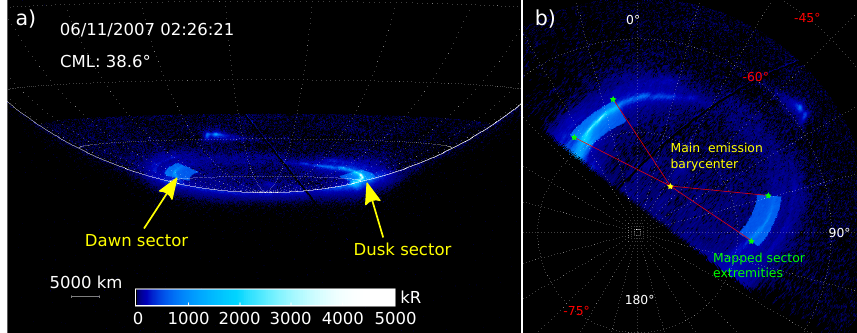
Figure 1. Panel (a) shows a background subtracted HST ACS image of the southern aurora of Jupiter. The brightness of the two sectors of interest has been enhanced. The emitted power is extracted from this image. As shown on panel (b) , the two sectors of interest are latitudinally defined according to the appropriate reference contour for the main emission, and their longitudinal extent corresponds to sectors 2 local-time hour long on the dawn and dusk side projected into the ionosphere along magnetic field lines following the model of Vogt et al. (2015) with VIPAL for a radial distance of 30R J . These mapped positions are shown with green